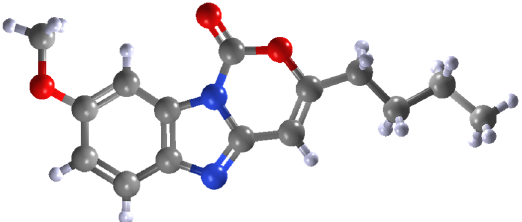
Figure 2. Molecular structure of 3-butyl-8-methoxy-1 H -benzo[4,5]imidazo[1,2- c ][1,3]oxazin-1-one 2c . Color legend: carbon (light grey), hydrogen (white), oxygen (red), nitrogen (blue) (CCDC 2051334).